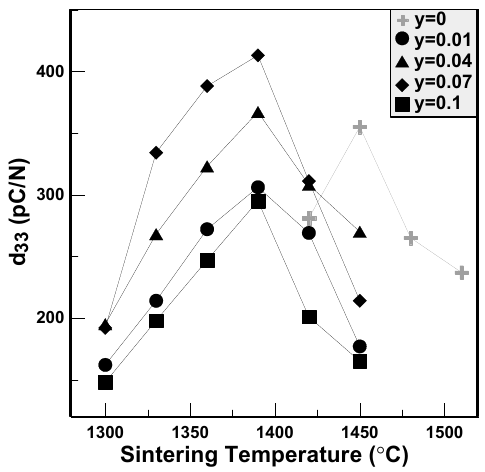
Figure 6. The piezoelectric constants of the BCTS–yLiF sheets.